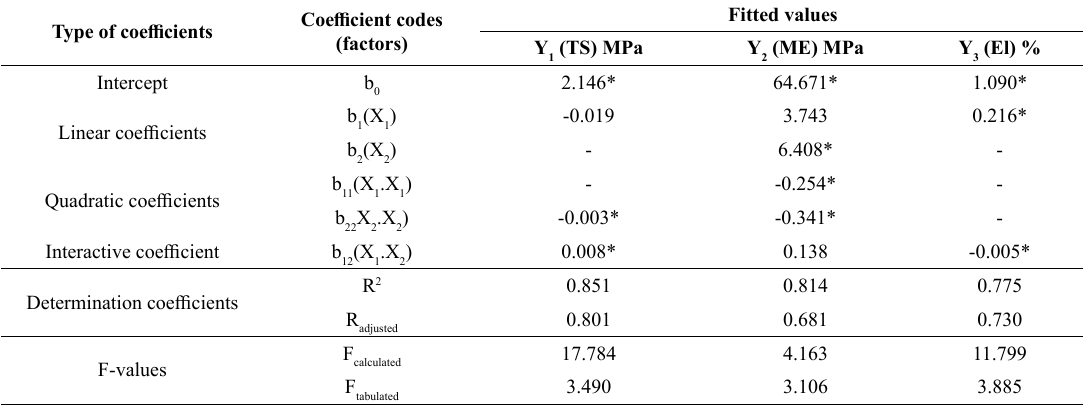
Table 2. Regression, determination coefficients and F test for models, as described in Equation 1, for response variables, with Y strength (TS), Y = modulus of elasticity (ME) and Y 2